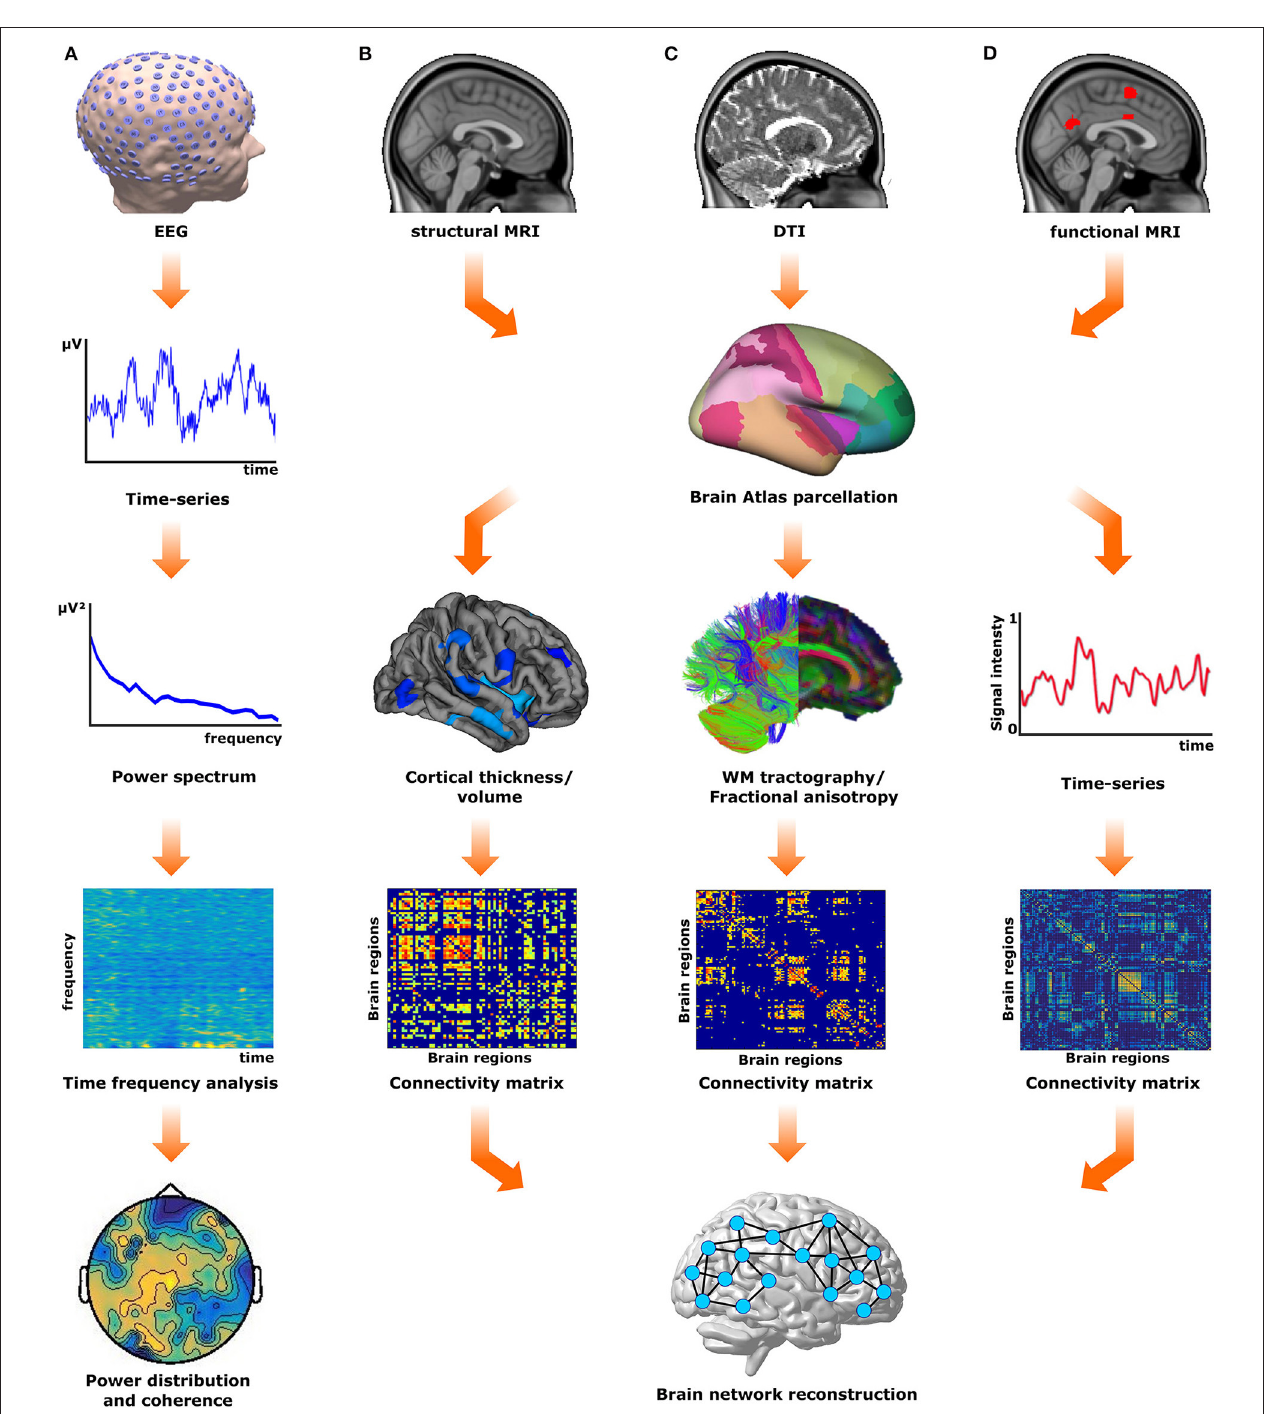
FIGURE 1 | Overview of network reconstruction methods. (A) The electrical activity of the brain is recorded using electroencephalography (EEG). These recordings (EEG time-series) are analyzed using time-frequency analysis approaches to investigate the spatiotemporal distribution of the frequency power. (B) From structural (T1) magnetic resonance images (MRI) morphological measures (cortical thickness/volume) for different brain regions can be extracted according to a predefined atlas. These measures are used to obtain a structural covariance matrix, from which the structural gray matter network is reconstructed. (C) The diffusion tensor images (DTI) are used to derive white matter tracts, from either probabilistic or deterministic tractography algorithms, or fractional anisotropy maps. These measures are used to obtain a connectivity matrix according to the brain atlas of choice, and subsequently, the structural white matter network is reconstructed. (D) The functional MRI (fMRI) time series from different brain regions obtained can also be used to generate the functional connectivity matrix and subsequently to reconstruct the functional brain network.